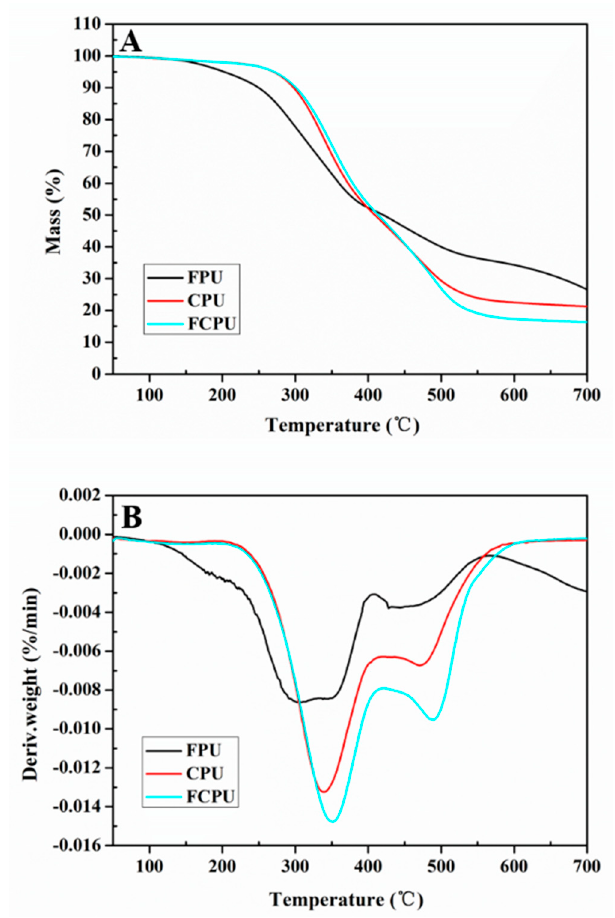
Figure 7. TGA ( A ) and DTG ( B ) curves of FPU, CPU and FCPU coating materials.